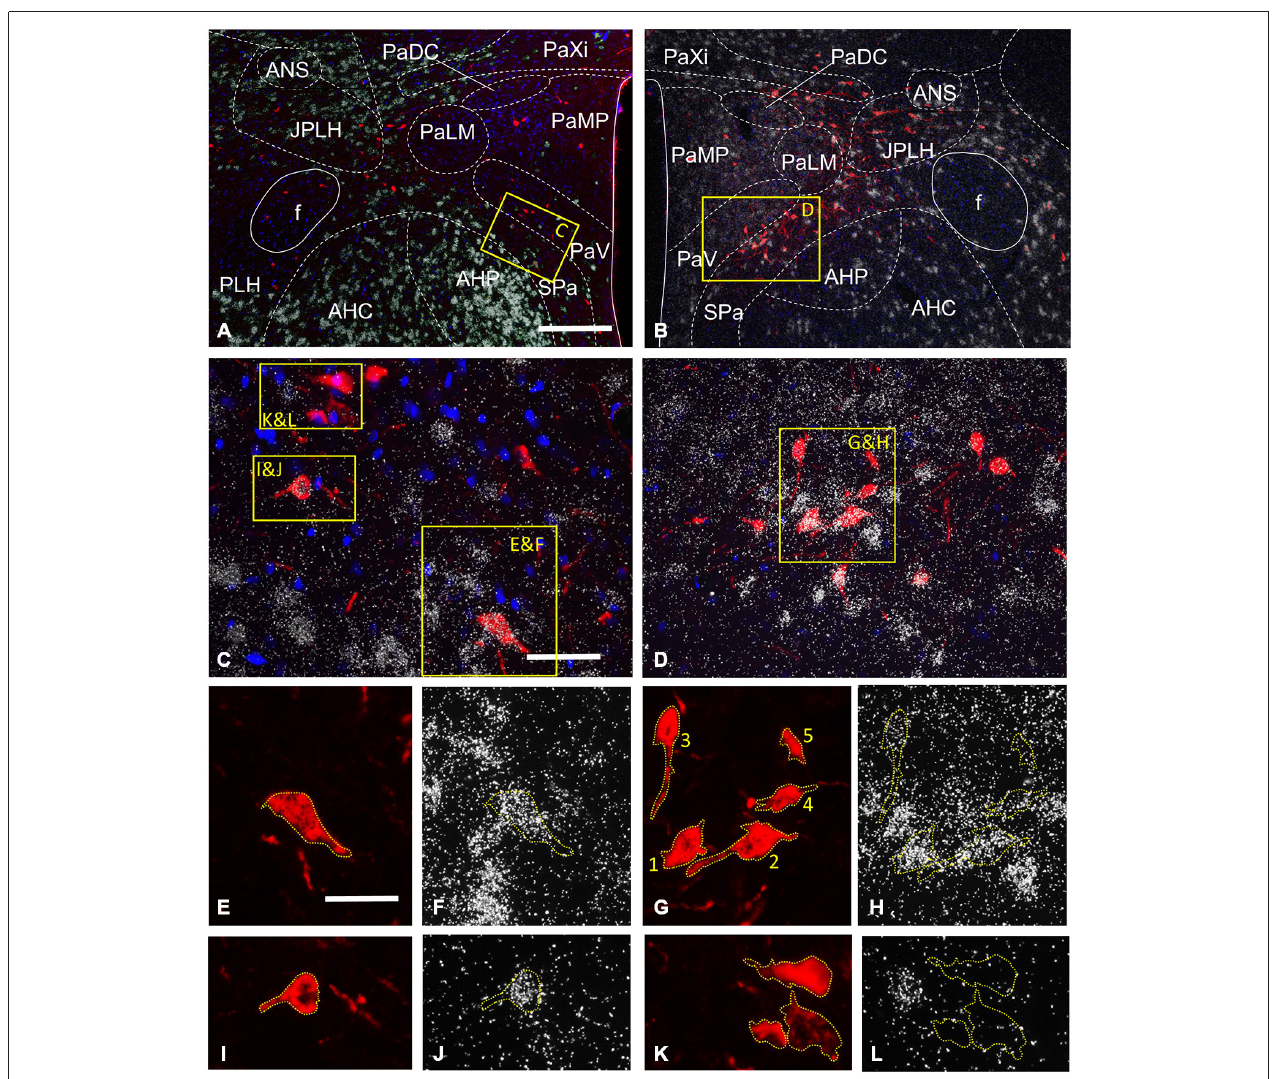
FIGURE 4 | Expression of the GABAergic (GAD 65 mRNA) and glutamatergic (VGLUT2 mRNA) markers by CTB-labeled hypothalamic neurons projecting to the VTA, as detected in two representative sections by the combined use of in situ hybridization (ISHH) and immunohistochemistry. At the level of the paraventricular nucleus (Pa), CTB-IR neurons are detected in different subnuclei of the Pa, the juxtaparaventricular (JPLH) and peduncular (PLH) parts of the lateral hypothalamus and the subparaventricular zone of the hypothalamus (Spa; A,B) . Neurons with intense GAD65 mRNA expression are found in the anterior hypothalamic nuclei (AHP and AHC), the JPLH and SPa, and a few scattered cells also appear in the Pa (A). A moderate vGLUT2 mRNA signal is present in the Pa, in contrast with the AHP, AHC, JPLH and SPa which contain neurons with high level of expression (B). The yellow enframed areas in (A,B) are magnified to (C,D) , respectively. These images illustrate the SPa and the neighboring AHP and the ventral part of the Pa at medium power. The indexed yellow boxes are further magnified to single channel images, which show the signal either for CTB (E,G,I,K) or the mRNAs of GAD65 (F,J,L) or VGLUT2 (H) . The immunoreactive sites for CTB are in red due to the used fluorescent label (E,G,I,K) , whereas the autoradiographic signal marking mRNAs appear as white dots, due to the deposition of silver grains, were photographed at dark field illumination (F,H,J,L) . Yellow dashed lines are used—in both single channel images to highlight the position of the retrogradely-labeled cells under the silver grains. There are two CTB-positive cells expressing GAD65 mRNA in the SPA (E,F,I,J) , in contrast those in the PaV are not labeled for this marker of GABAergic neurons (K,L) . The autoradiographic signal varies from cell to cell, as exemplified by (G,H) ; there are retrogradely-labeled cells showing strong autoradiographic signal for VGLUT2 mRNA in the SPa (cell number 1 and 2), a moderate signal in the PaV (cell number 3 and 4) and a signal, which fell below the threshold for considering as double-labeled (cell number 5). Scale bars: 200 µ m for (A,B) , 50 µ m for (C,D) , 25 µ m for (E,L) .